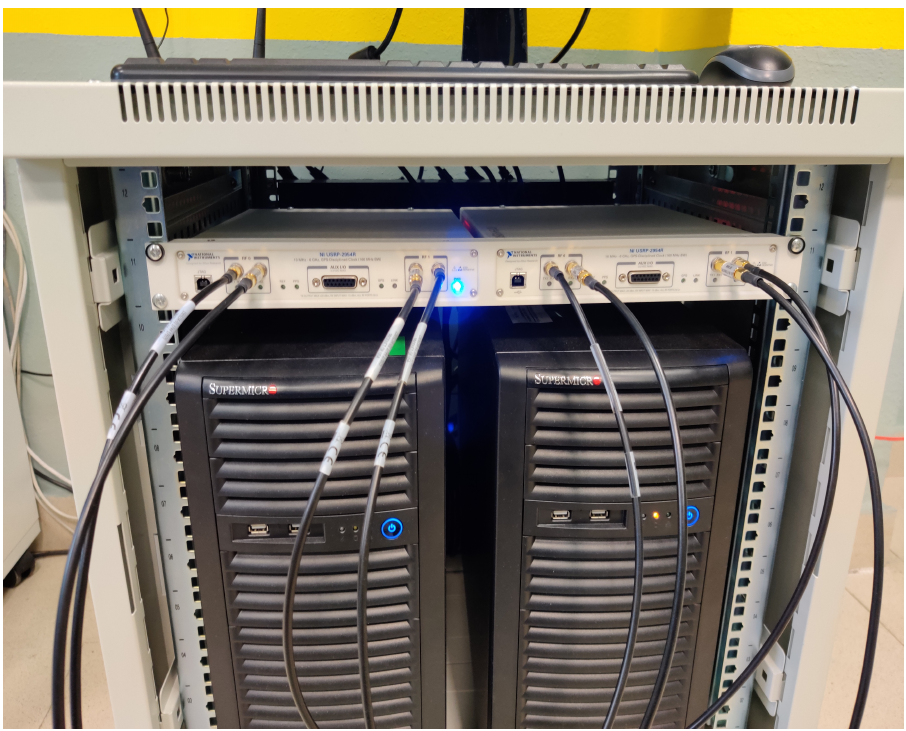
Figure 8. Architecture of the prototype system.